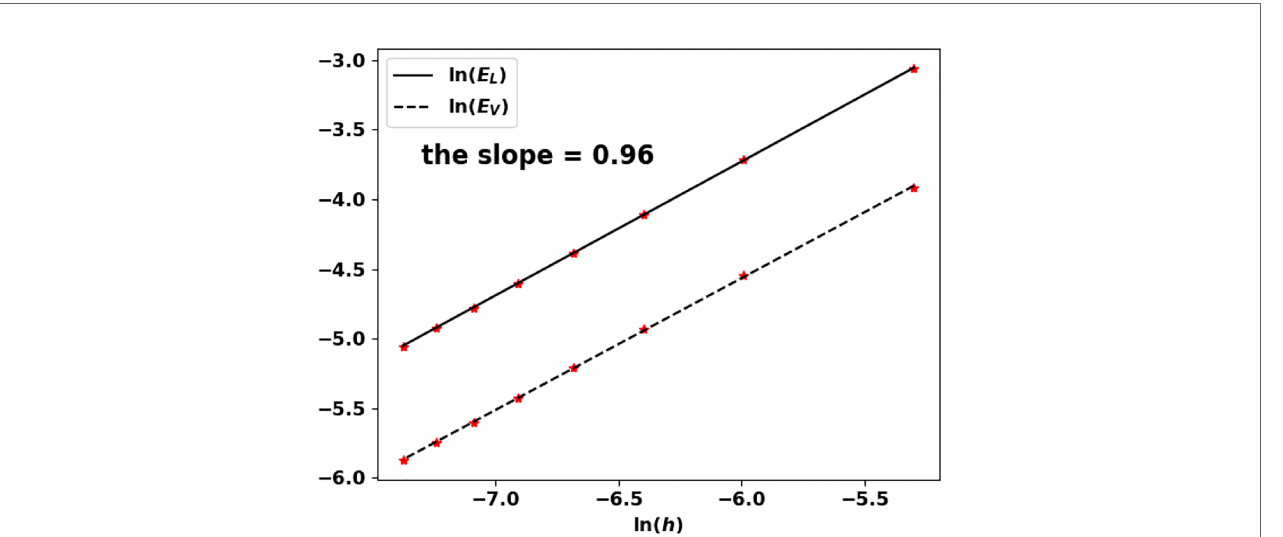
FIGURE 12 | Uniform fragmentation, ex. 2 case n = 1: rate of convergence to the exact eigenpair with respect to h .